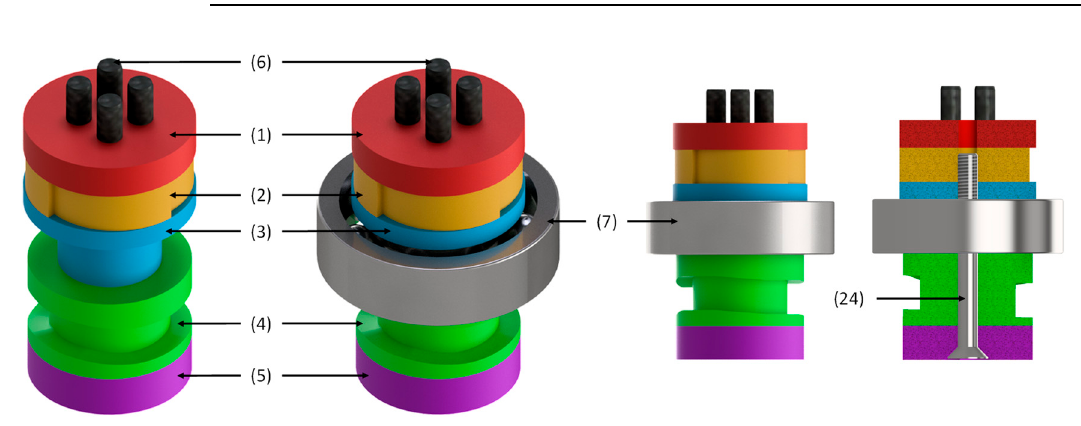
Figure 2. Actuators shaft.